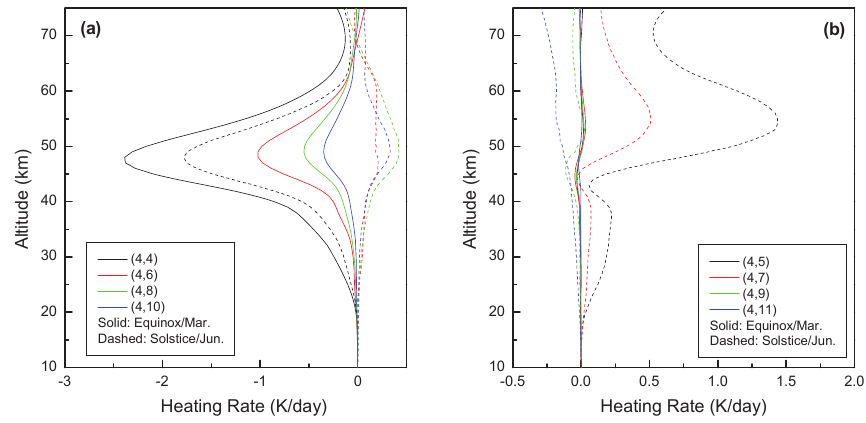
Fig. 17. The multi-year averaged vertical profiles of the symmetric (a) and asymmetric (b) 6-h Hough functions for equinox/March (solid line) and solstice/June (dashed